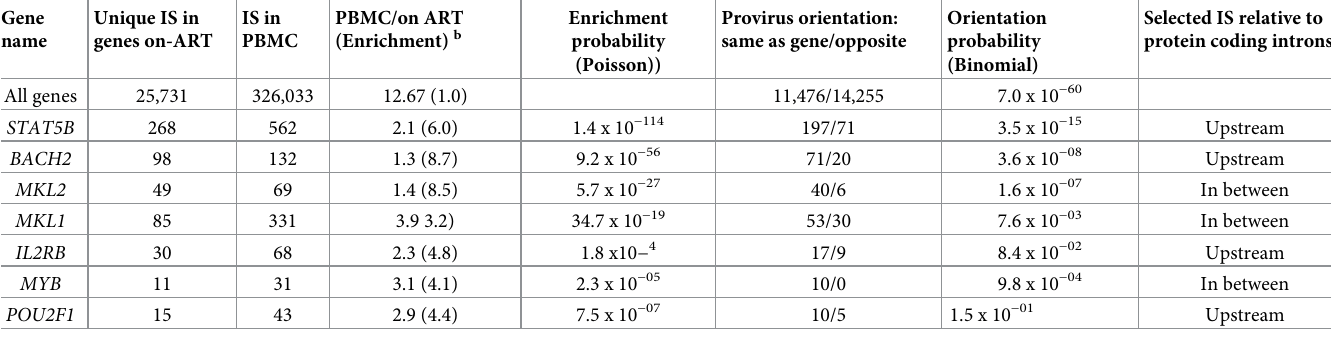
Table 3. Genes in which integrated provirus can be selected in vivo a